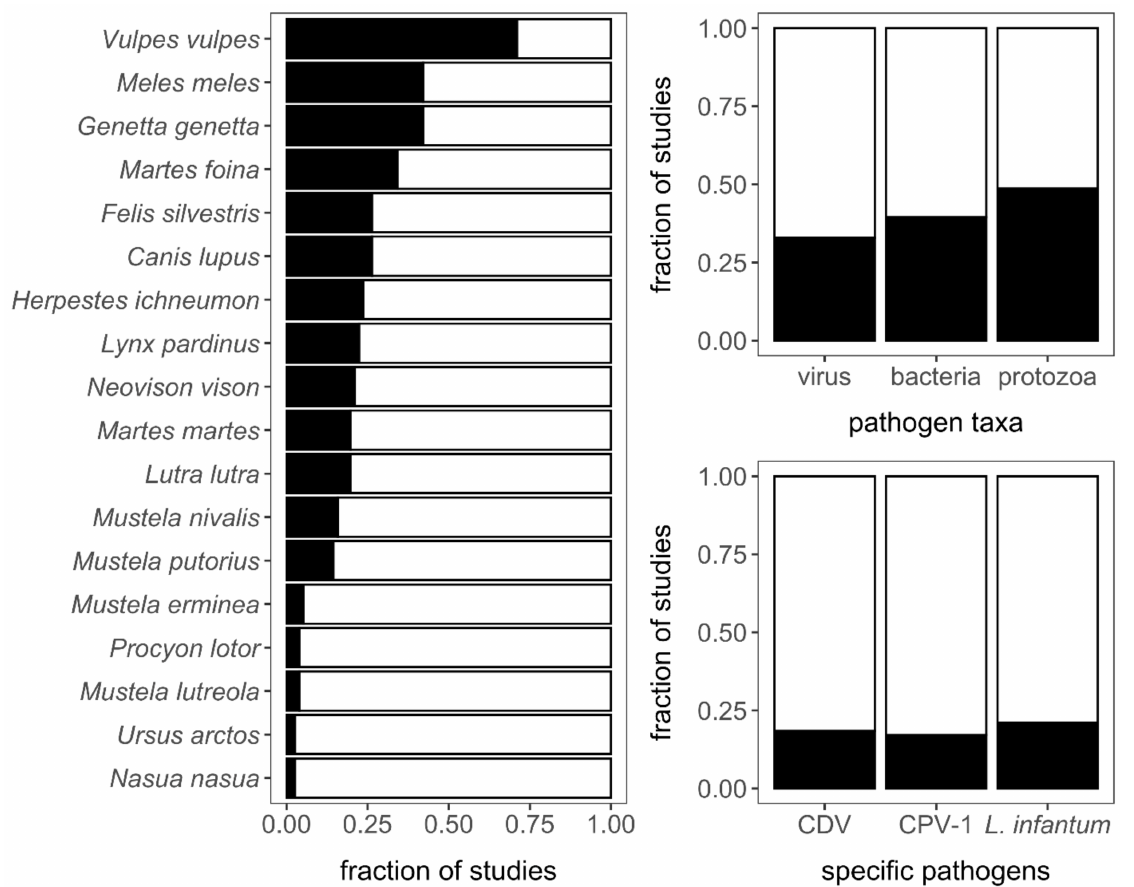
Figure 2. Composition of the 76 included Iberian carnivore microparasite studies according to host species, pathogen taxa, and the three most common